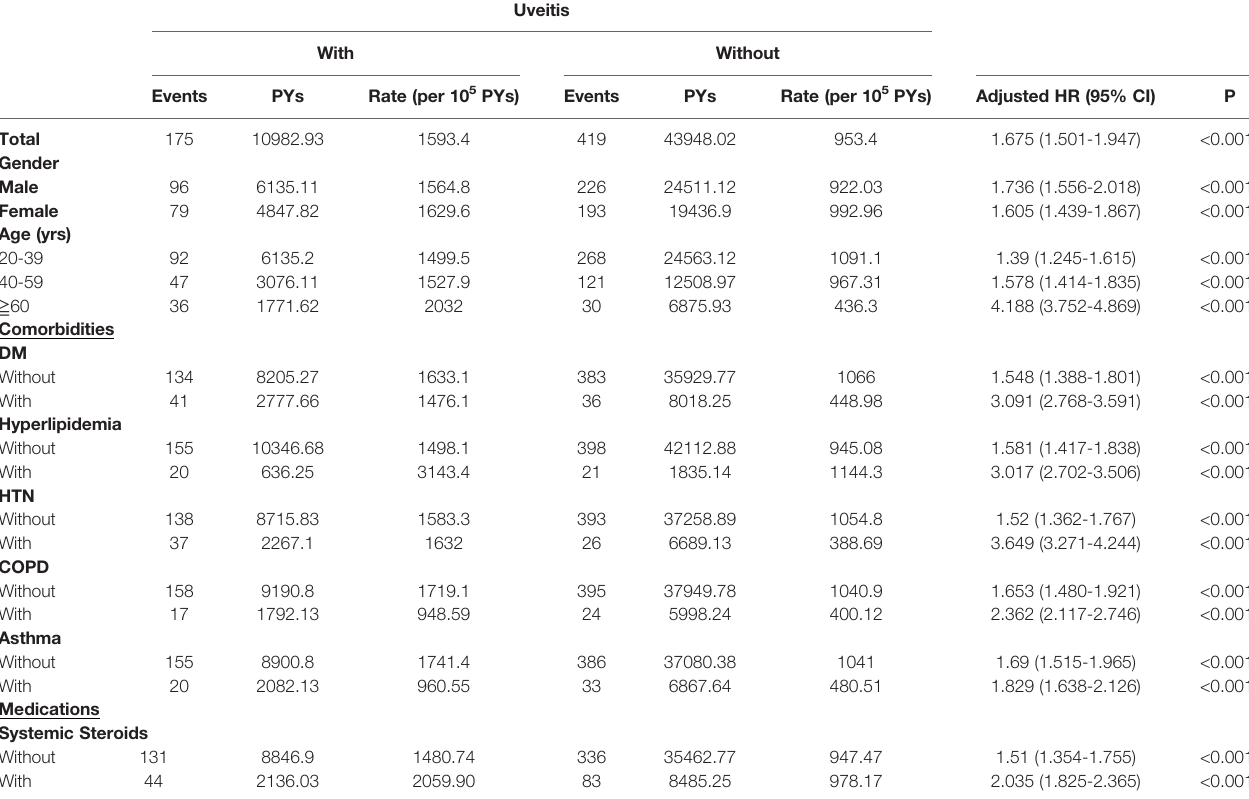
TABLE 3 | Factors of ACS strati fi ed by variables listed using Cox regression with Fine & Gray ’ s competing risk model.